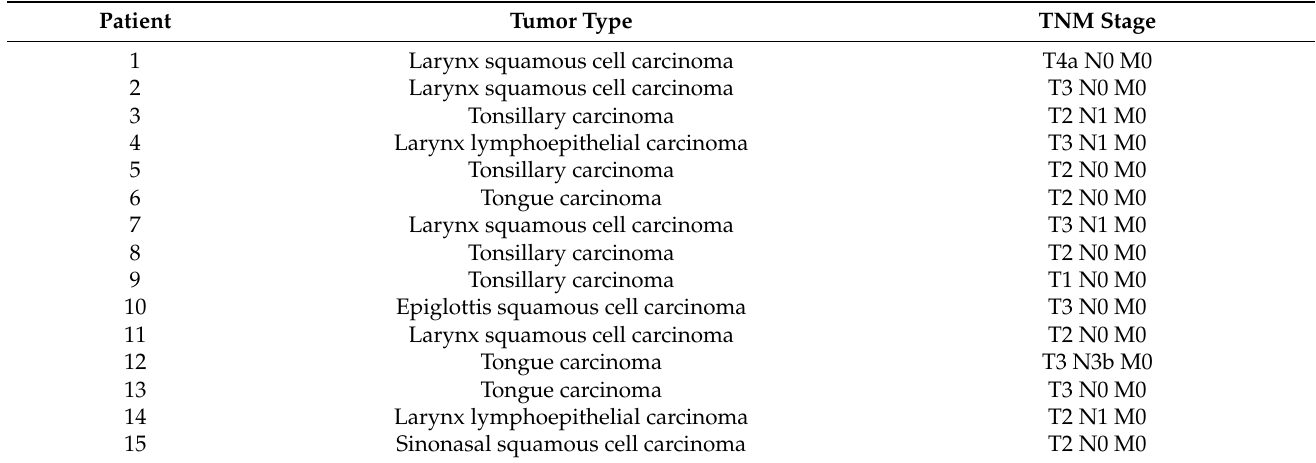
Table 2. Histology and TNM stage for the group of patients with HNC. T = tumor size; N = lymph nodes involvement; M = metastasis yes/no.